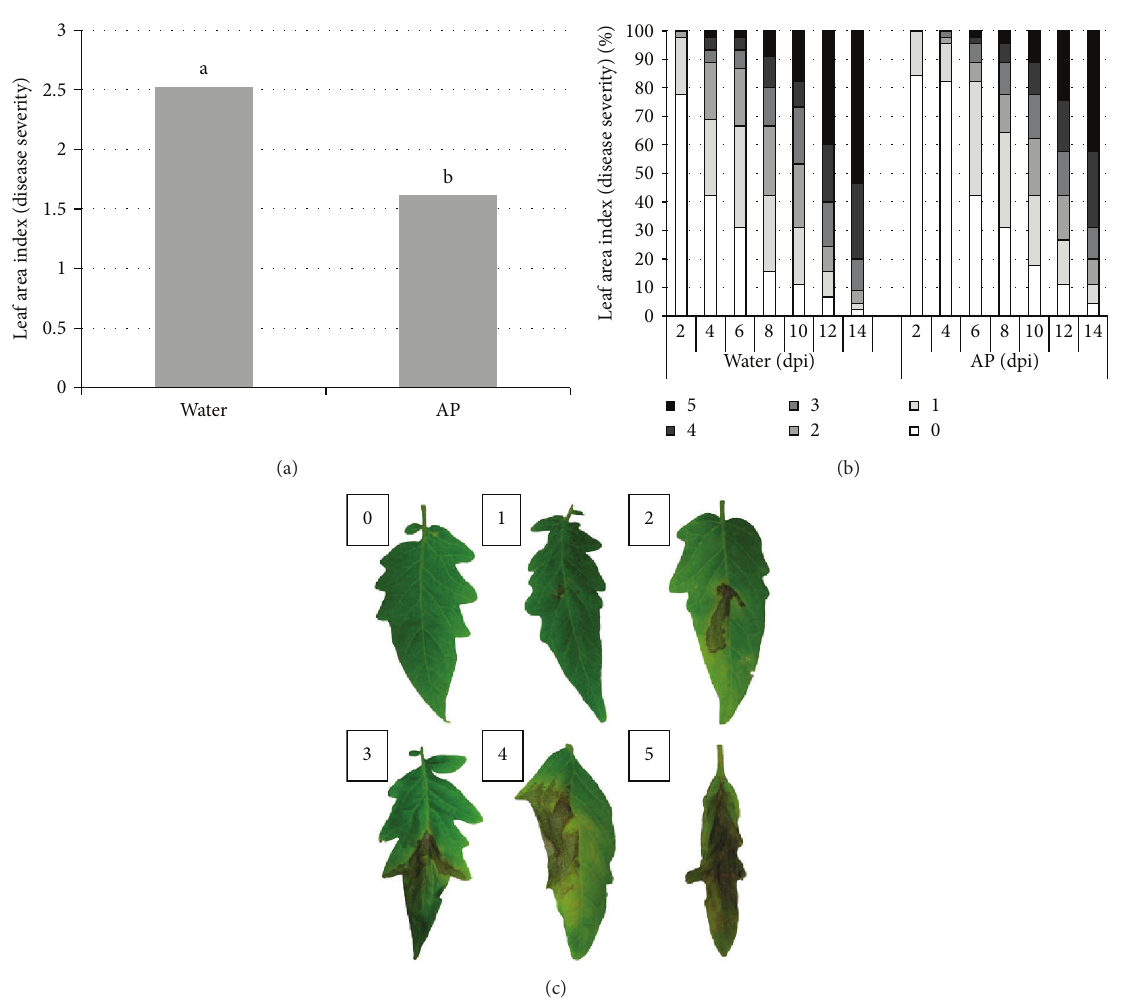
Figure2:Plantpathogen( S.lycopersicum cv.HouseMomotaro— P.infestans